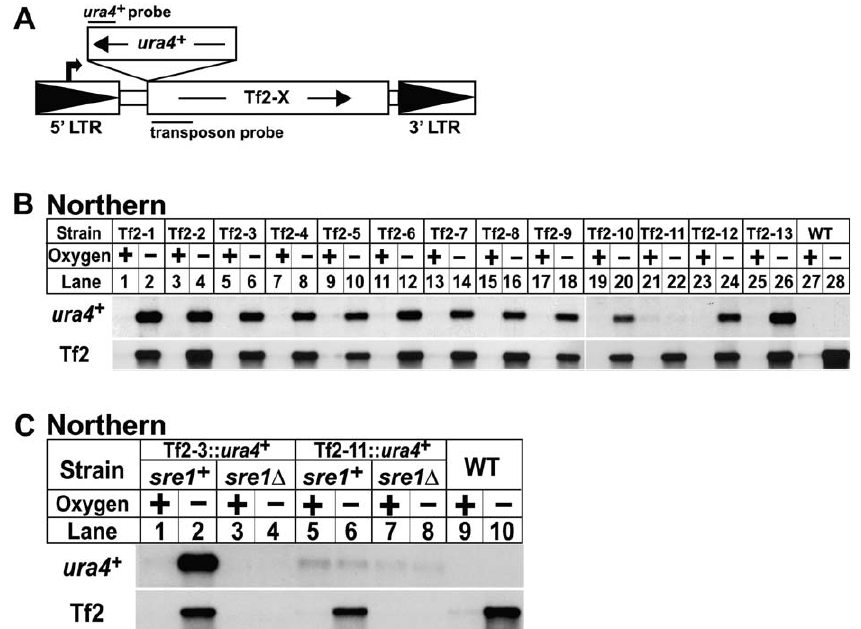
Figure 2. Sre1 Controls Low Oxygen Expression of Multiple Tf2 Elements (A) Scheme for tagging individual Tf2 elements with ura4 þ . Bold arrow denotes Tf2 transcription initiation. Northern probe positions are indicated. (B) Yeast containing a single Tf2 element tagged by ura4 þ or wild-type yeast were grown þ / (cid:2) oxygen for 8 h and processed for northern analysis using strand-specific DNA probes to detect either the tagged Tf2 element ( ura4 þ probe) or all 13 Tf2 elements (Tf2 probe). (C) Wild-type or sre1 D yeast containing a tagged Tf2 element were grown þ / (cid:2) oxygen for 6 h and processed for northern analysis. All Tf2 elements tested (Tf2–4, Tf2–7, and Tf2–10) gave results identical to Tf2–3.